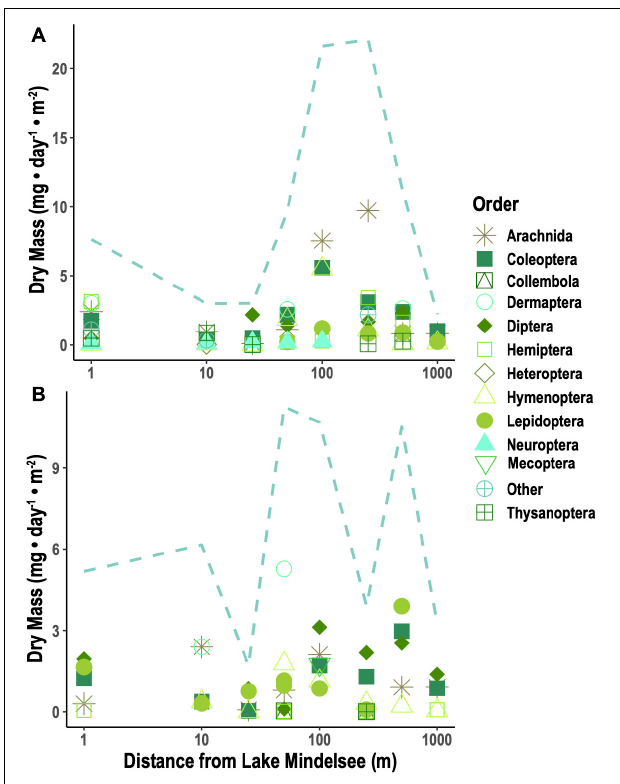
FIGURE 2 | Mean terrestrial arthropod biomass per taxa (points) and sum of mean biomass for all taxa (dotted lines) collected from Malaise traps in (A) April and (B) May. Lepidoptera include both adult and larval Lepidoptera (i.e., caterpillars) captured in Malaise traps.